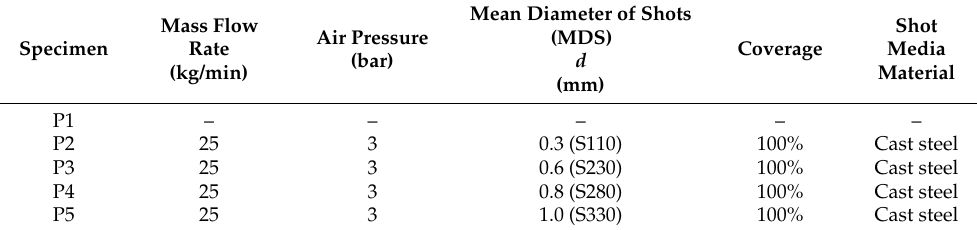
Figure 5. Schematic diagram of shot peening (SP) treatment for a hatch corner specimen. Table 2. The different SP parameters for T–welded joint